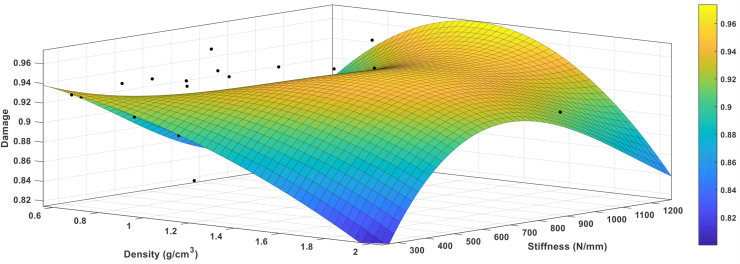
The sensitivity plot demonstrating the relation between damage, density, and stiffness.